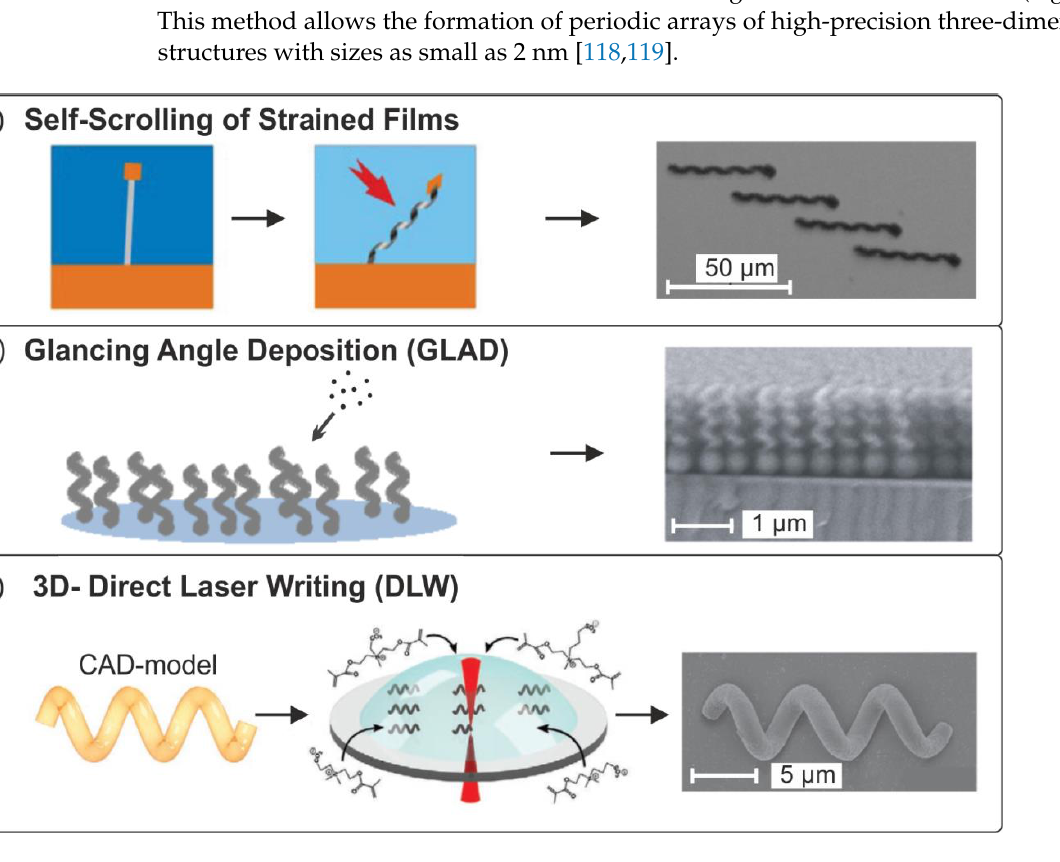
Figure 6. Fabrication methods of magnetic helical swimmers. ( a ) A method based on the self-rolling of a three-layer strained film with a nickel magnetic head [63]. Copyright 2009, American Chemical Society. ( b ) Glancing angle deposition (GLAD) method [120]. Copyright 2009, American Chemical Society. ( c ) Three-dimensional direct laser lithography (DLW) [117]. John Wiley & Sons (Hoboken,